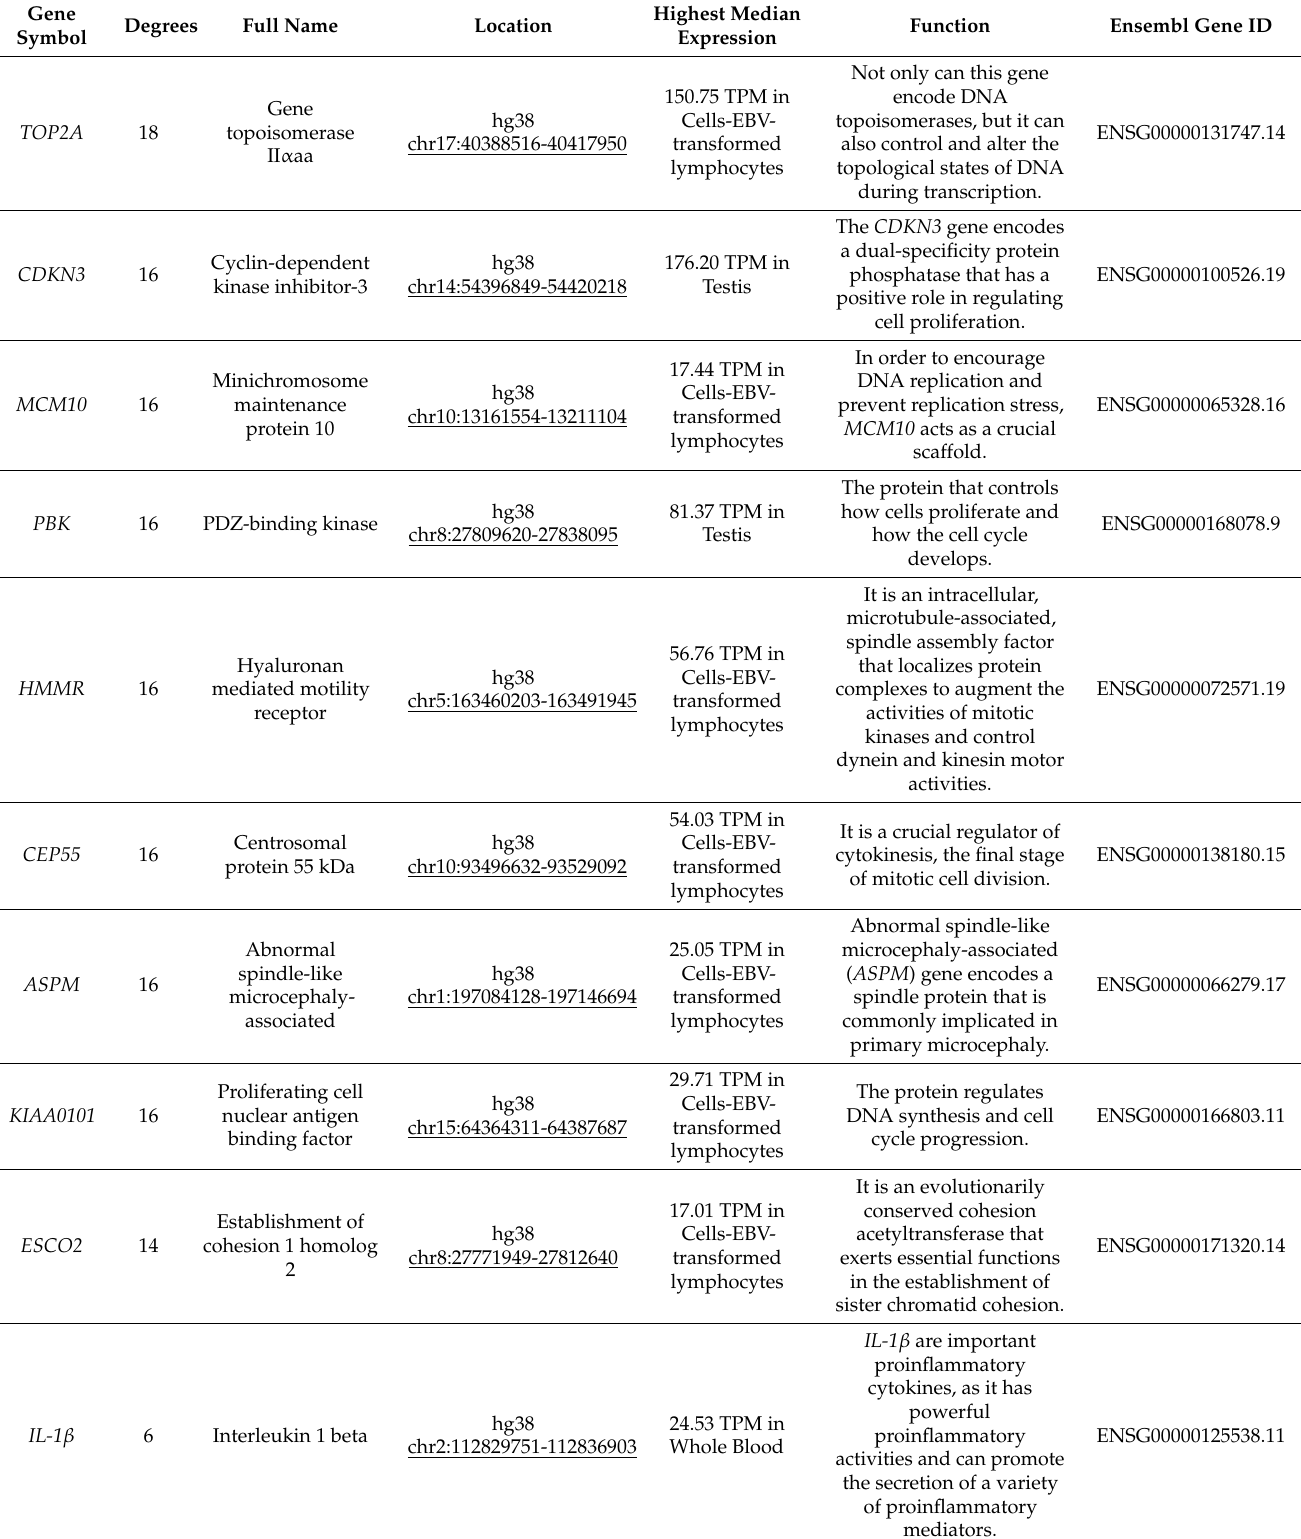
Table 1. Information on 10 hub